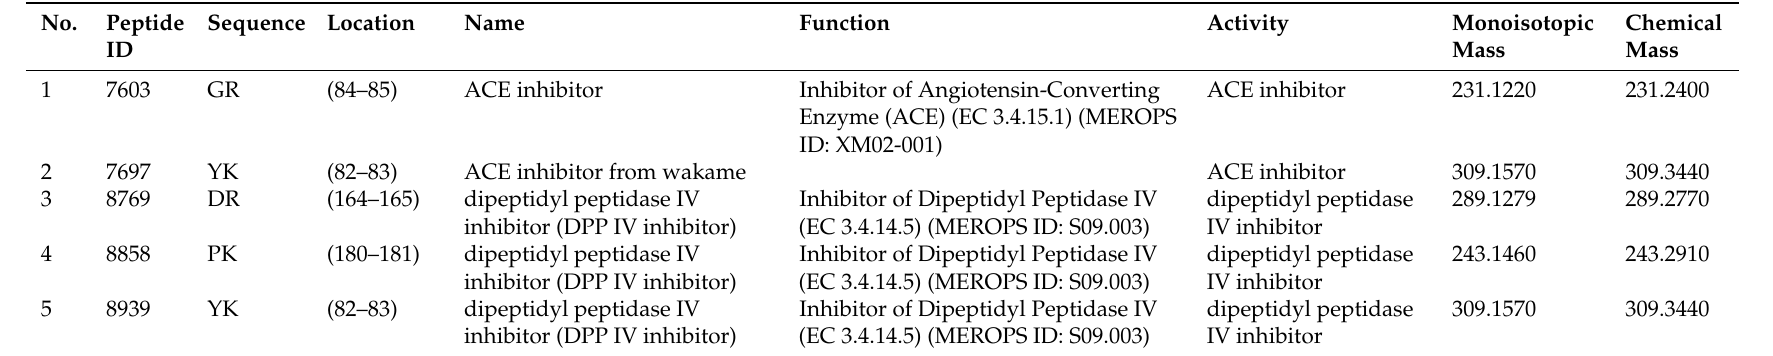
Table A3. Bioactive peptides from RubisCO of Halophila stipulacea . In silico enzymatic cleavage was carried out by using